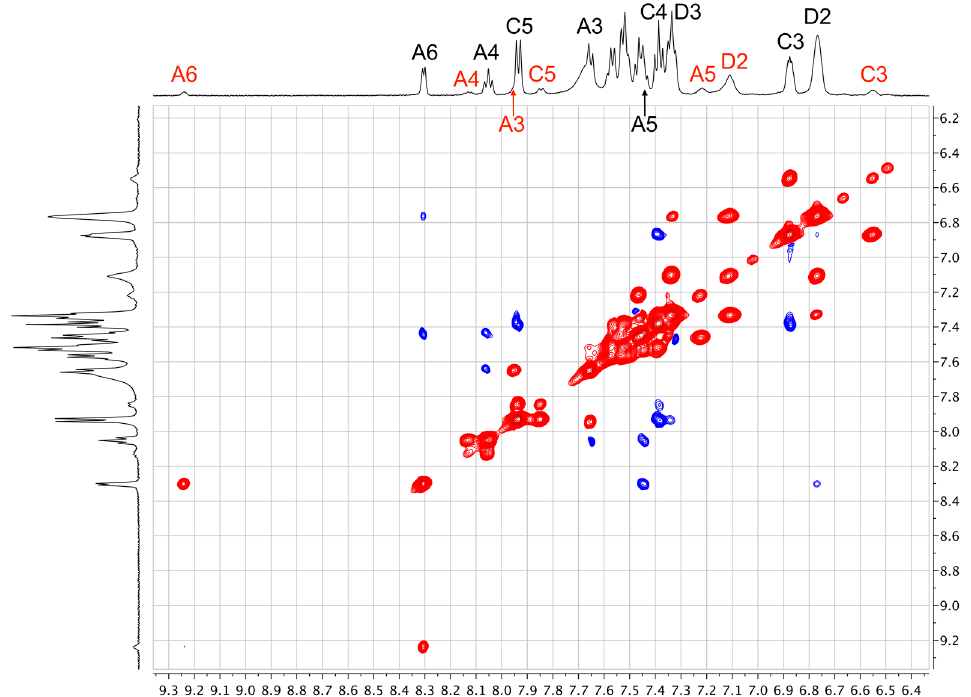
Figure 7. EXSY (red) and NOESY (blue) cross-peaks in the aromatic region of the ROESY spectrum of [Cu(xantphos)( t BuSPy)][PF 6 ] (500 MHz, acetone- d 6 , 198 K). Major species represented by black labels, minor by red labels. See Materials and Methods Section for full assignment of major species.